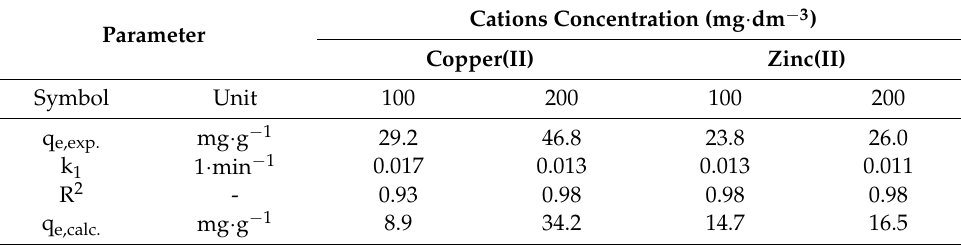
Table 4. Pseudo-first-order kinetic parameters obtained by linear method at different copper(II) and zinc(II) cation concentrations.